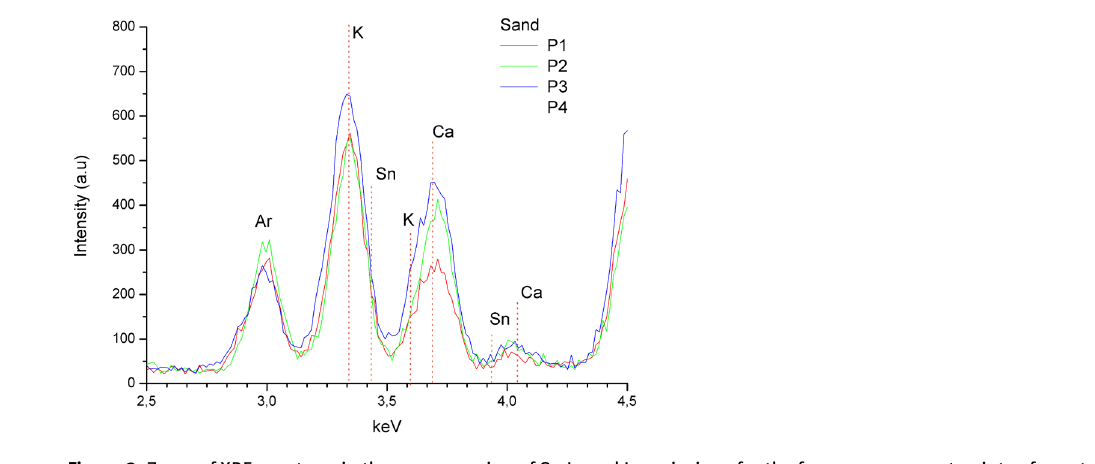
and L emissions for the four measurement points of quartz sand. α β